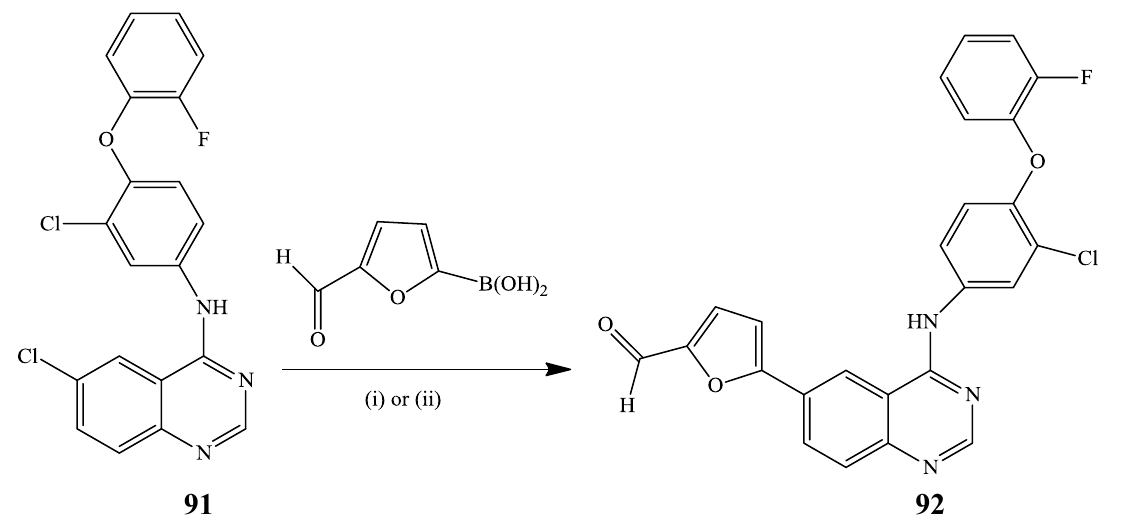
Reagents and conditions : (i) 10% Pd/C, NEt 3 , EtOH, 60 °C; (ii) PdCl 2 , KOAc.